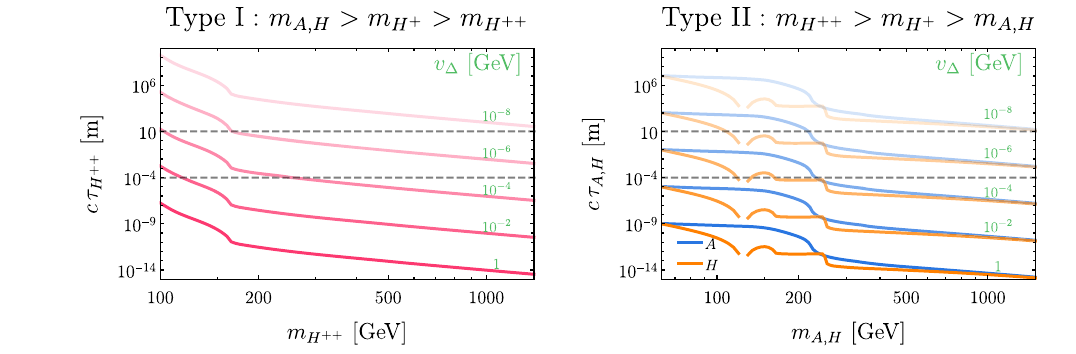
m H is restricted to be / ∈ ( 120 , 130 ) GeV since H maximally mixes with h there (see Appendix C for more details). For reference, we have drawn dashed lines representing c τ = 10 − 4 meter (corresponding to ∼ 10 − 12 sec, which is the typical B meson lifetime) and 10 meter. This is the range in which long lived particle searches at the LHC could be